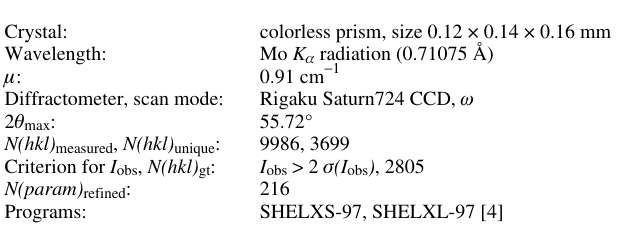
Table 1. Data collection and handling.